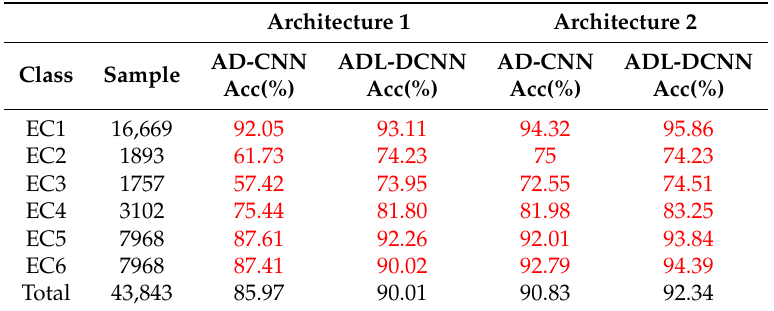
Table 1. Prediction accuracy of enzymatic function in different models with two architectures.